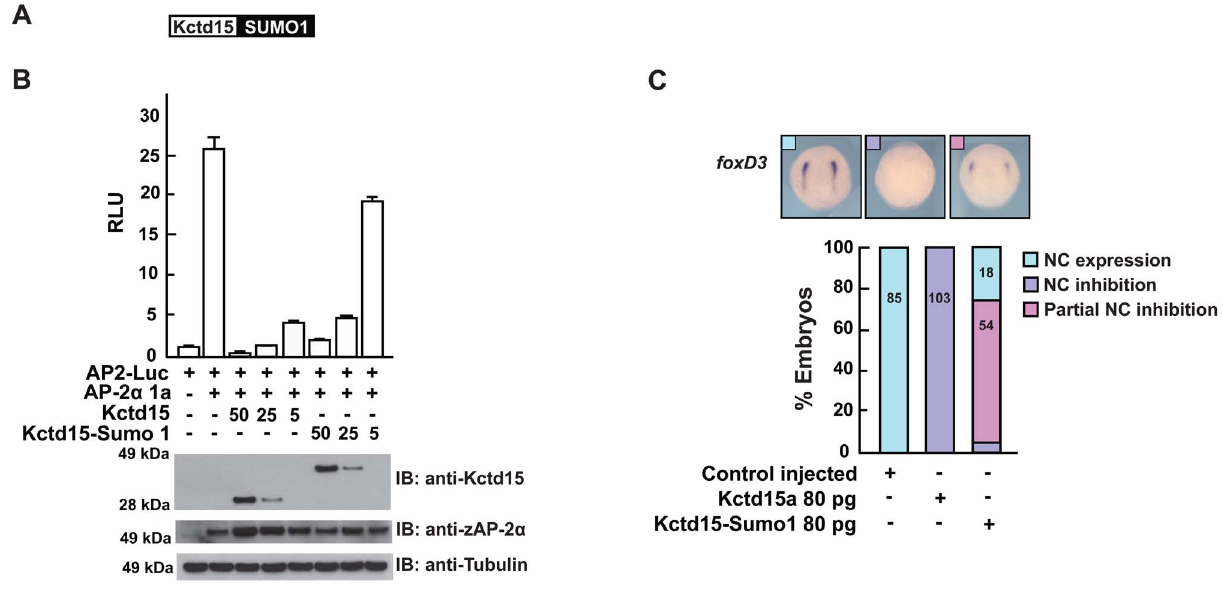
Figure 5. Kctd15 conjugated to SUMO1 is less competent in inhibiting AP-2 a activity and NC formation. (A) Diagram of the fusion protein between Kctd15 and SUMO1. (B) Kctd15-SUMO1 conjugated protein was less effective than WT in repressing AP-2 a dependent reporter activation. (C) Injection into zebrafish embryos of Kctd15-SUMO1 failed to abolish NC formation.